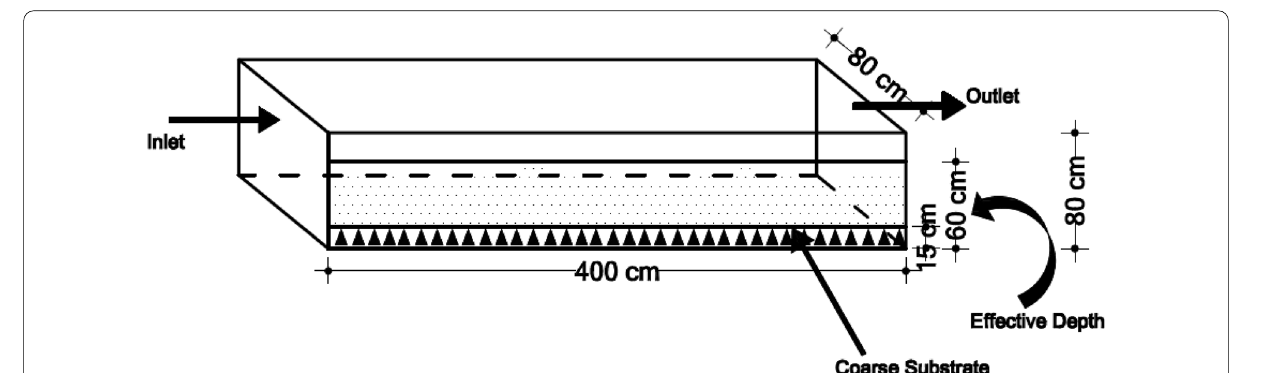
Fig. 3 Side view of horizontal subsurface flow constructed